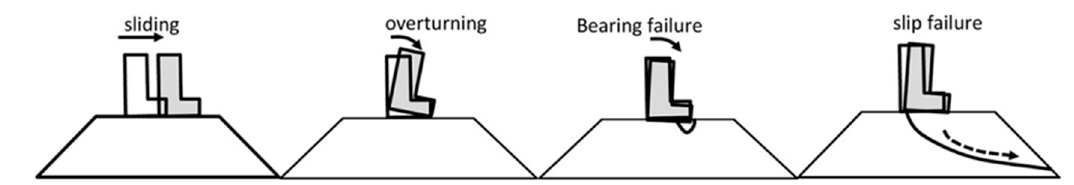
Figure 1. Breakwater modes of failure (adapted from Pedersen [2]).